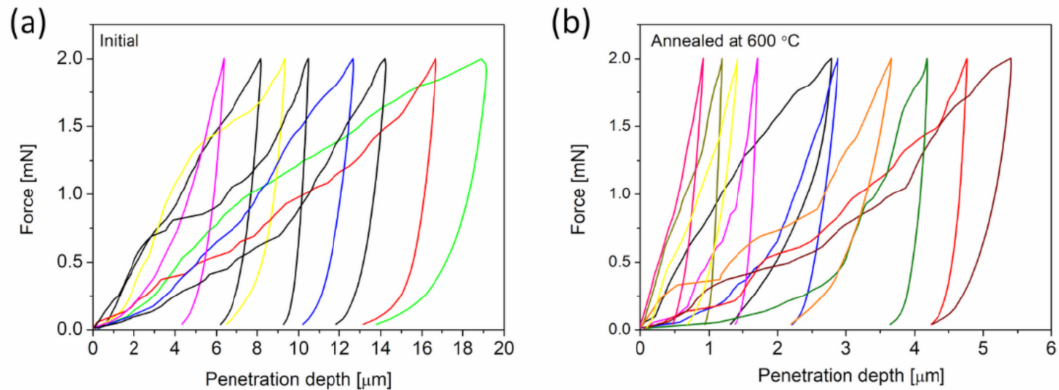
Figure 7. Force versus penetration depth curves obtained by nanoindentation from Cu foam materials that were processed by route C ( a ) and the counterpart material that was annealed at 600 ◦ C for 5.5 h after dealloying ( b ).